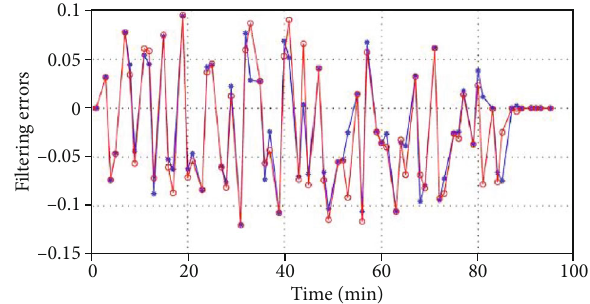
Figure 1: Actual route and predictive